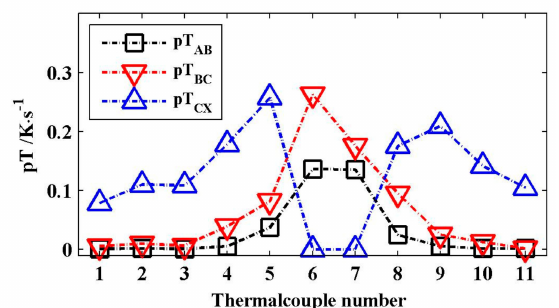
Figure 8. Average temperature rates of three stages in Figure 6: pT AB and pT BC , respectively, correspond to the two intervals of AB and BC. pT CX corresponds to the intervals between C and each